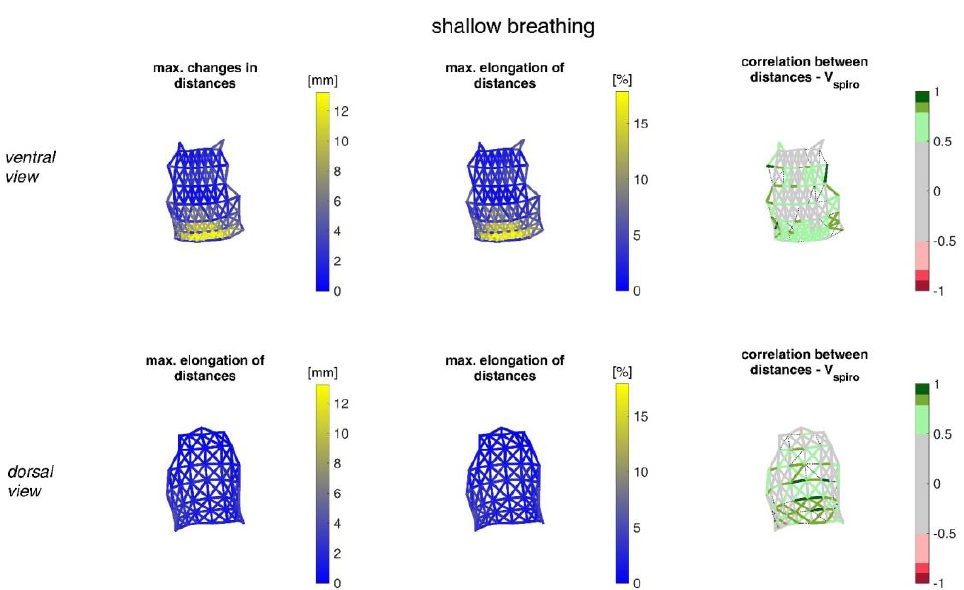
Figure 13. Illustration of the maximal distance changes amongst all subjects during shallow breathing ( left ), the corresponding distance elongation of all subjects ( center ), and the mean corresponding correlation of distance changes with V spiro of all subjects during shallow breathing ( right ). ( Top — ventral view, bottom —dorsal view). The dotted lines are distances, which do not fulfil ( p < 0.05). Figure 14 illustrates distance changes between neighbouring MoCap markers and their correlation with V spiro during maximal breaths.